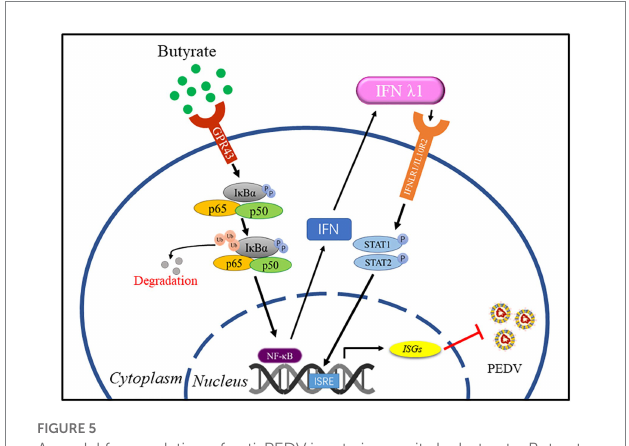
FIGURE 5 A model for regulation of anti-PEDV innate immunity by butyrate. Butyrate through activation of GPR43 and NF- κ B, leading interferon responses and induction of downstream antiviral genes inhibition of PEDV